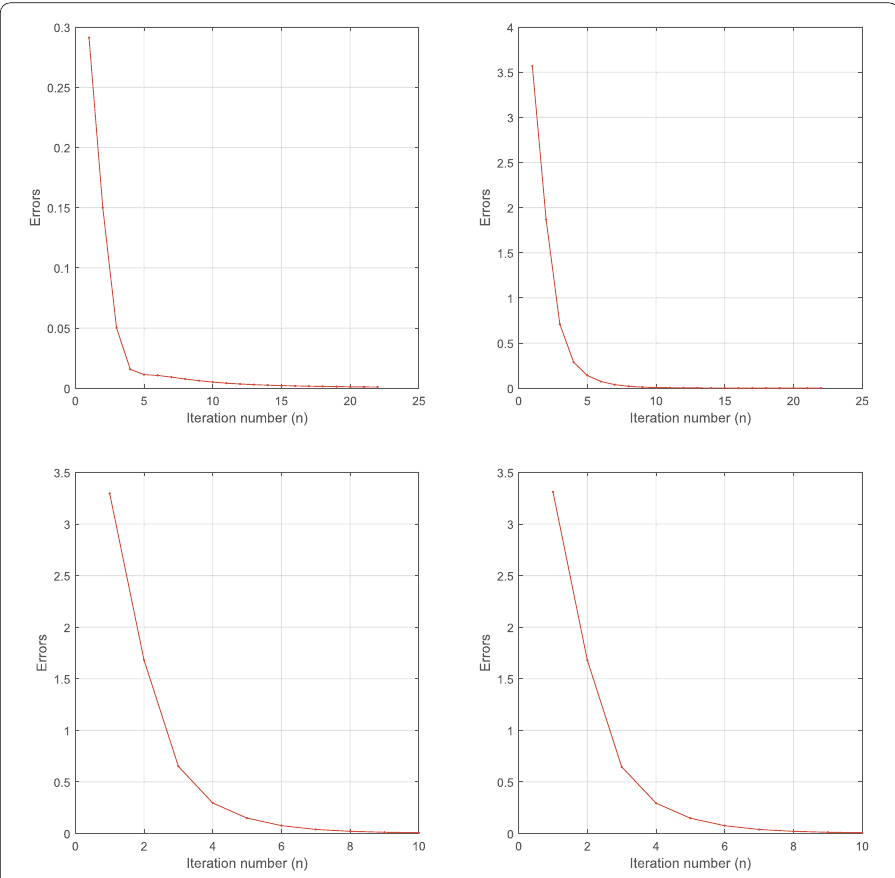
Figure 1 Errors vs. iteration numbers (n): Case I(a) (top left); Case I(b) (top right); Case II(a) (bottom left); Case II(b) (bottom